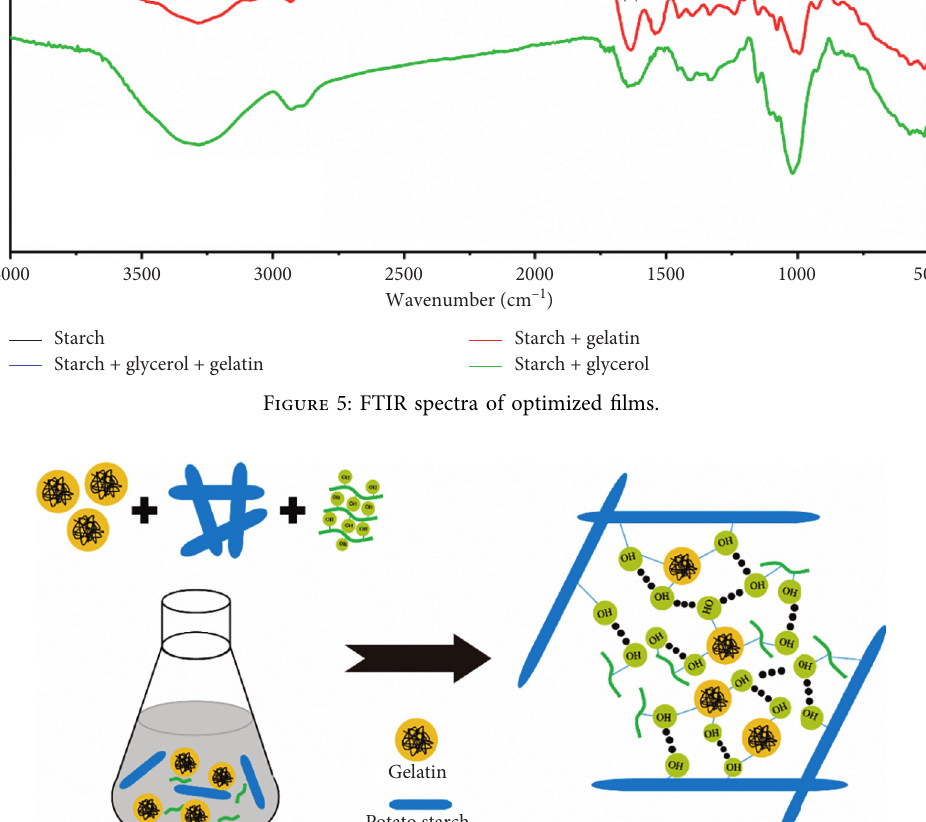
Figure 6: The schematic diagram of composite